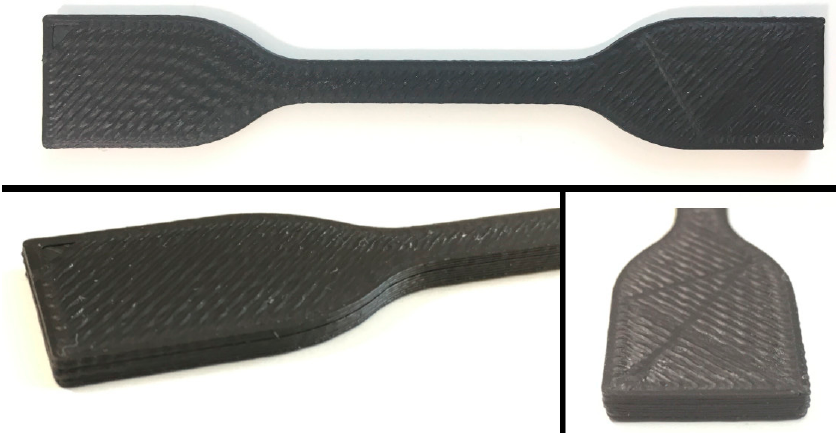
Figure 5. 3D printed samples for mechanical and electrical measurements printed from acryloni- trile butadiene styrene/carbon nanotube (ABS/CNT) composites. Quality of the samples is accepta- ble for further